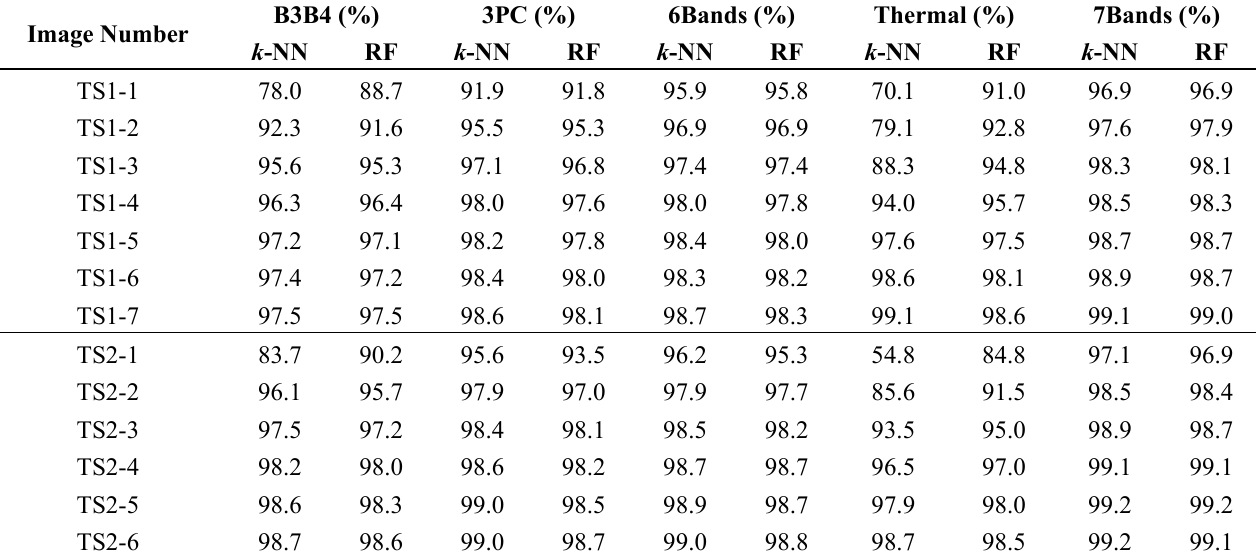
Table 7. Overall Accuracy of Level 1 classification by k-NN and Random Forest based on the time series images of the combination of band 3 and band 4 (B3B4), the first three principal components (3PC), the combination of 6 bands (6Bands), the thermal bands and the combination of 7 bands